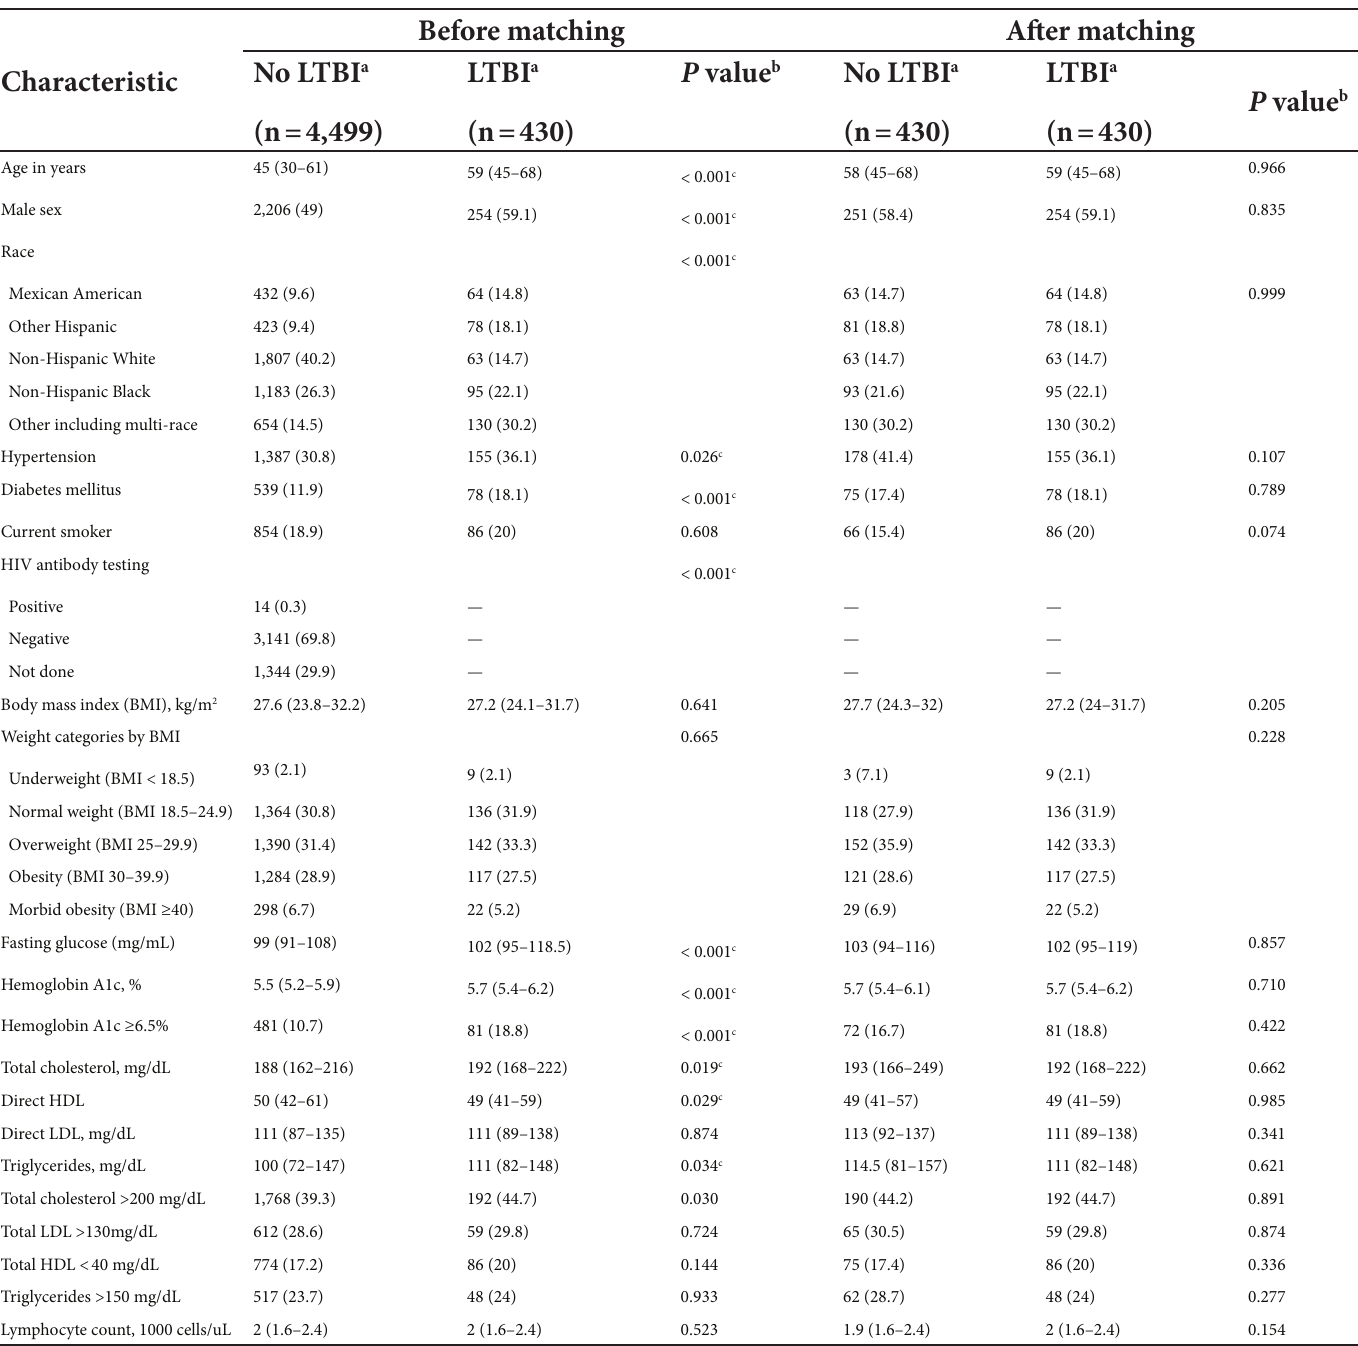
Table 1. Characteristics of the study